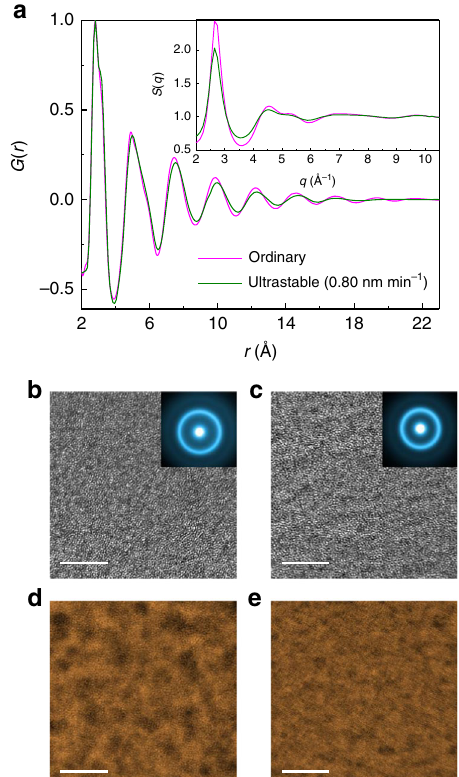
Fig. 3 Structure characterization for the ordinary and the 0.80 nm min − 1 deposited ultrastable glasses. a Pair distribution function G ( r ) and static structure factor S ( q ) (the inset) for the ordinary and the ultrastable MGs. b , c HRTEM images of b the ordinary and c the ultrastable MGs. Insets: selected area electron diffraction (SAED) patterns taken from a large selected area. d , e HADDF-STEM images of d the ordinary and e the ultrastable MGs. The scale bars in b – e are 5